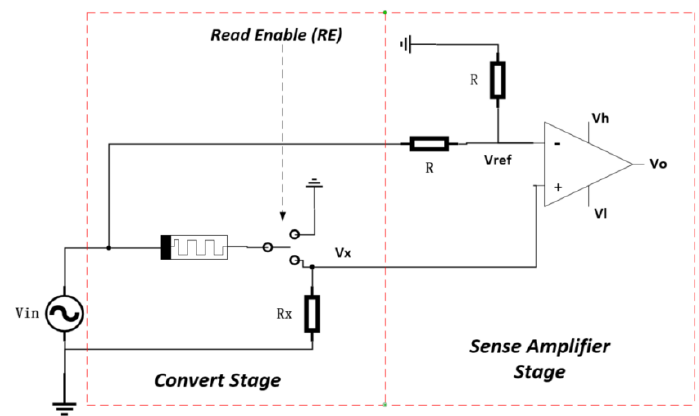
Figure 3. Nonvolatile memristor memory (NMM) [18].